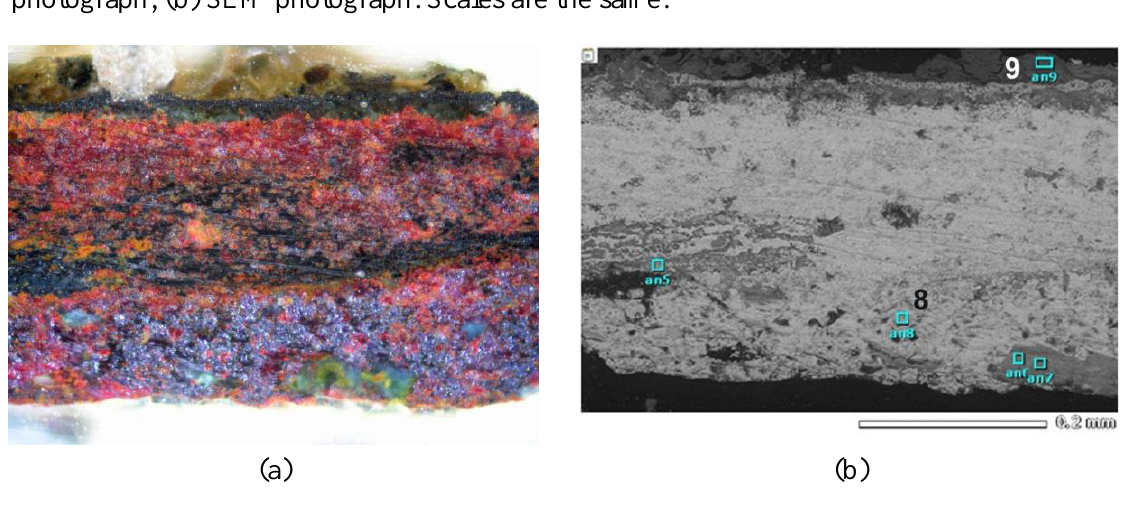
Figure 26. Cross-section images of the micro-sample from bronze fibula: (a) microscope photograph; (b) SEM photograph. Scales are the same.